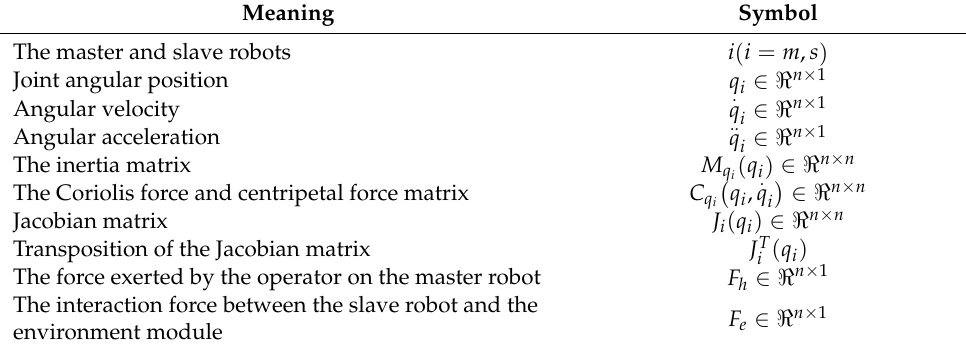
Table 1. Symbol meaning. Meaning Symbol